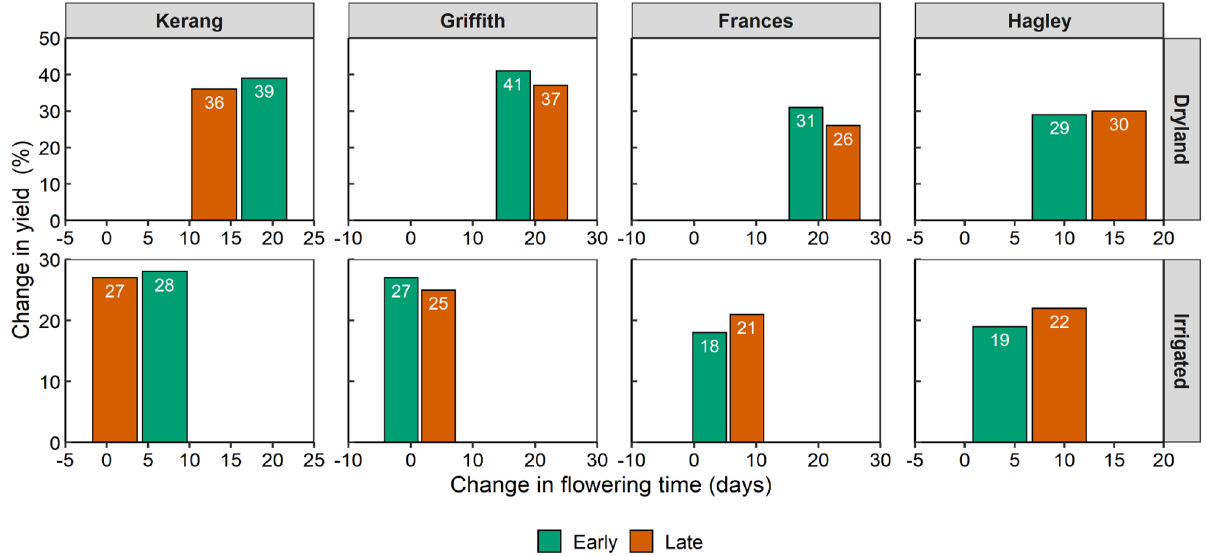
Figure 4. Impacts of future climates on optimal flowering times and yield. Columns show relationships between shift in optimal flowering duration (days) and percentage reduction in peak yield for early (green columns) and late (brown columns) maturity genotypes of durum wheat in dryland (top row) and irrigated (bottom row) conditions across a range of representative environments in Australian irrigated cropping regions. Future (2070–2089) climates truncated crop lifecycles, shifting forward flowering times relative to historical (1985–2004) climates. Irrigation partially offset the forward shifts in flowering by lengthening